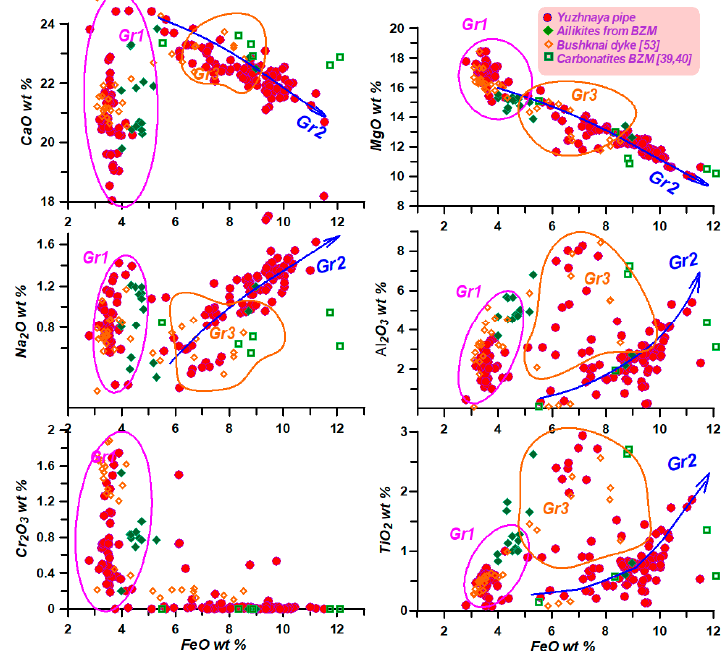
Figure 14. Variations of clinopyroxene compositions from aillikites of YuP, BZM and Bushkanai